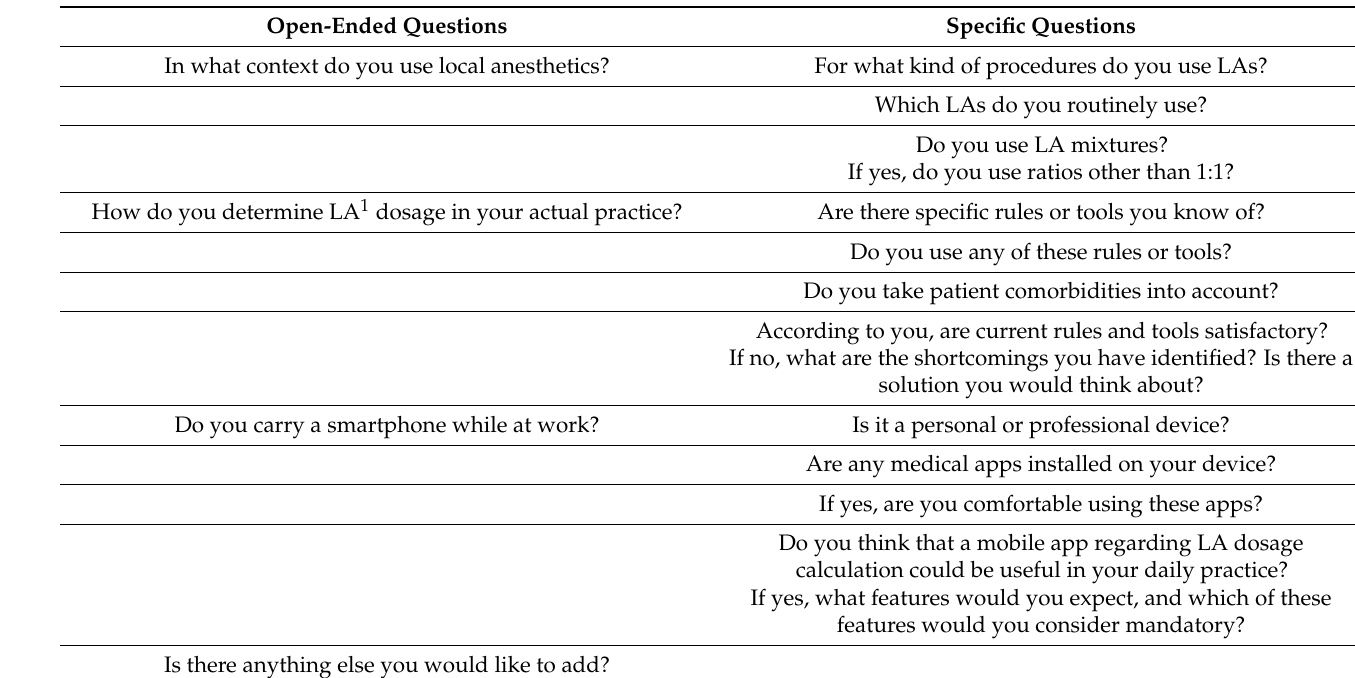
Table 1. Questions asked during the semi-structured